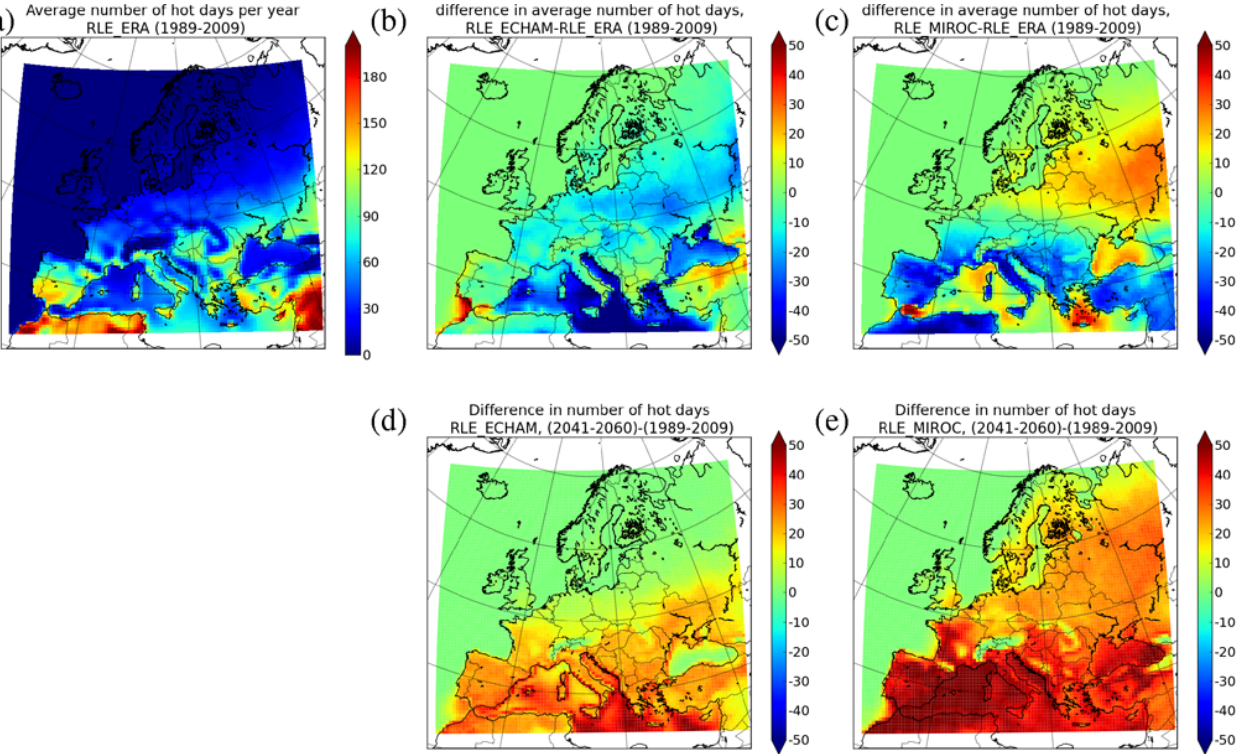
Fig. 3. Average number of summer days ( T max > 25 ◦ C). (a) Present-day RLE ERA, (b) difference present-day RLE ECHAM and RLE ERA, (c) difference present-day RLE MIROC and RLE ERA, (d) difference future climate and present-day climate RLE ECHAM, and (e) difference future climate and present-day climate RLE